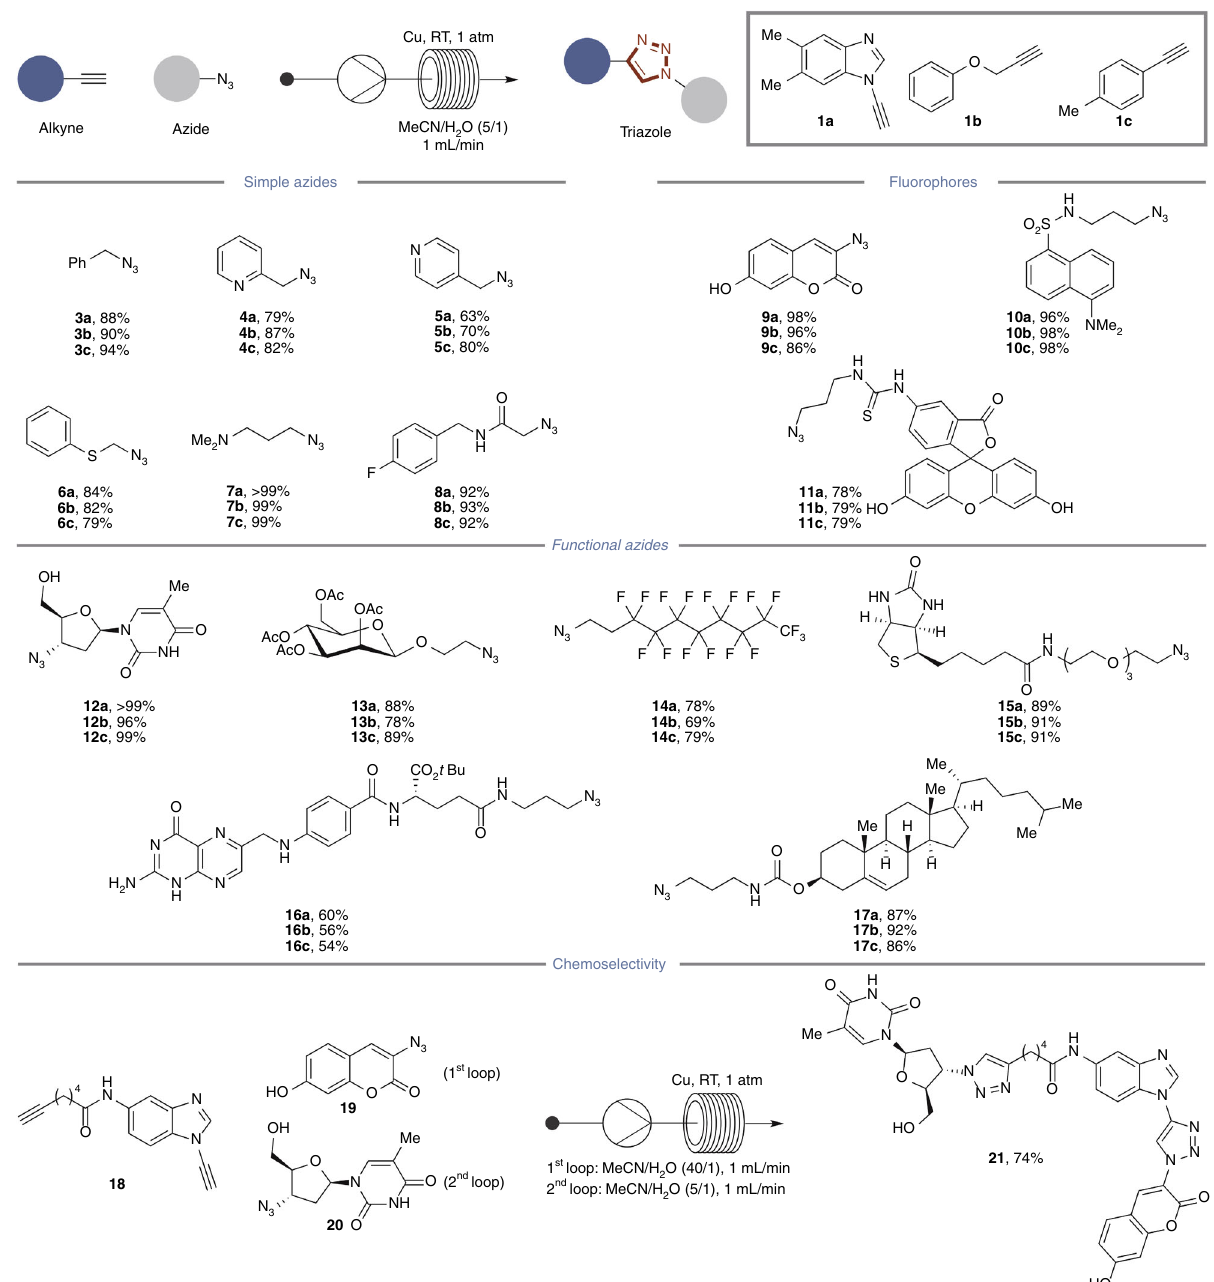
Fig. 3 Scope of the fl ow CuAAC process. For each product number (in bold), data are reported as percent isolated yield. Products with designation a are derived from alkyne 1a , b from alkyne 1b , and c from alkyne